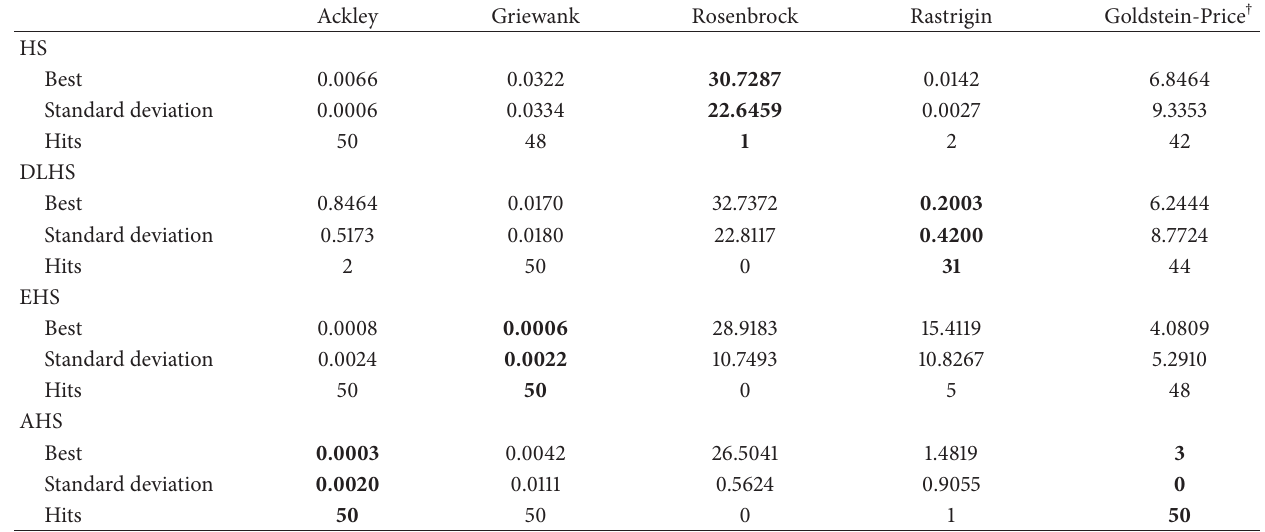
Table 2: Average scores and standard deviations over 50 runs for 30-dimensional problems. All optimisers were allowed to run for 100,000 function evaluations, except when the Goldstein-Price polynomial was being minimised. In that case, 10,000 evaluations were allowed. The best results from each benchmark function are indicated in bold.